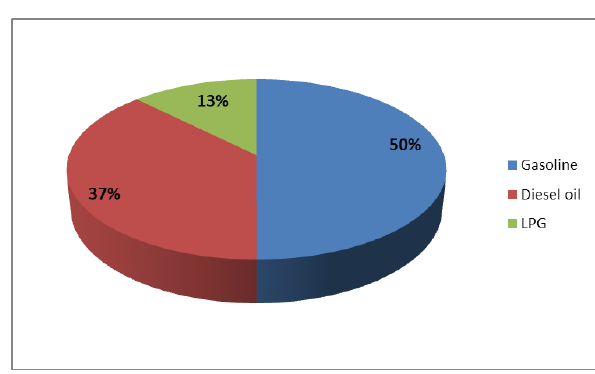
Figure 2: The share of vehicles powered by different fuels in the total number of vehicles in Poland in 2017 [4].